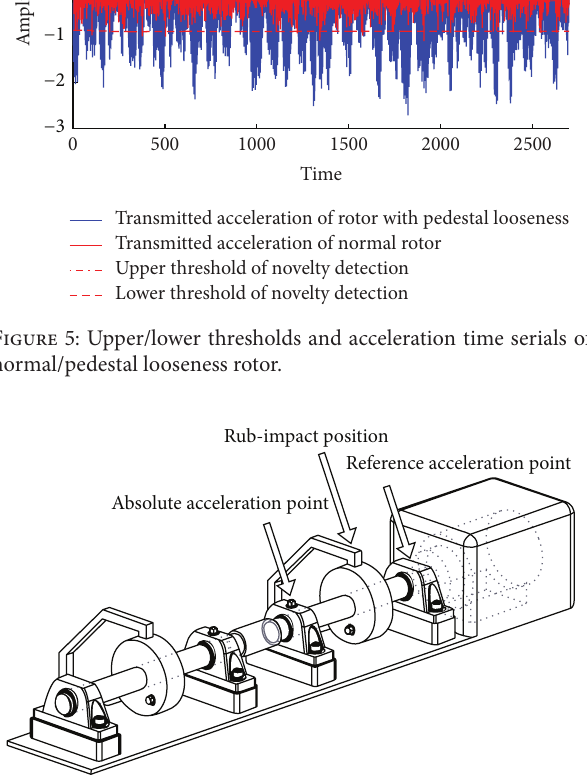
Figure 6: Cascade rotor system for vibration transmission measure- ment of rub-impact rotor.